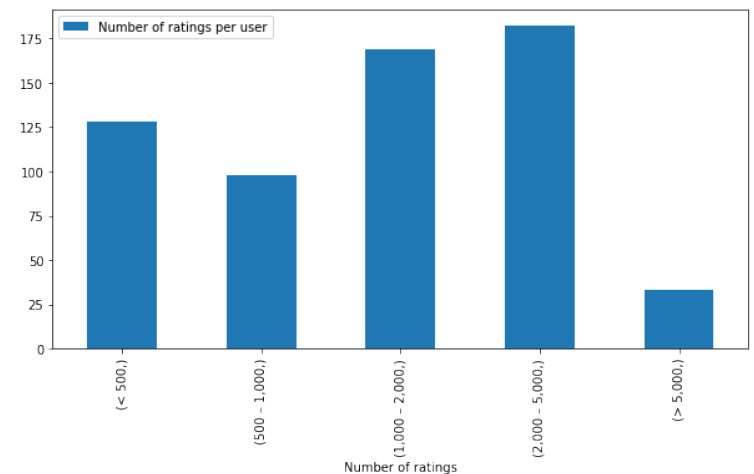
Figure 6. Number of rating per user